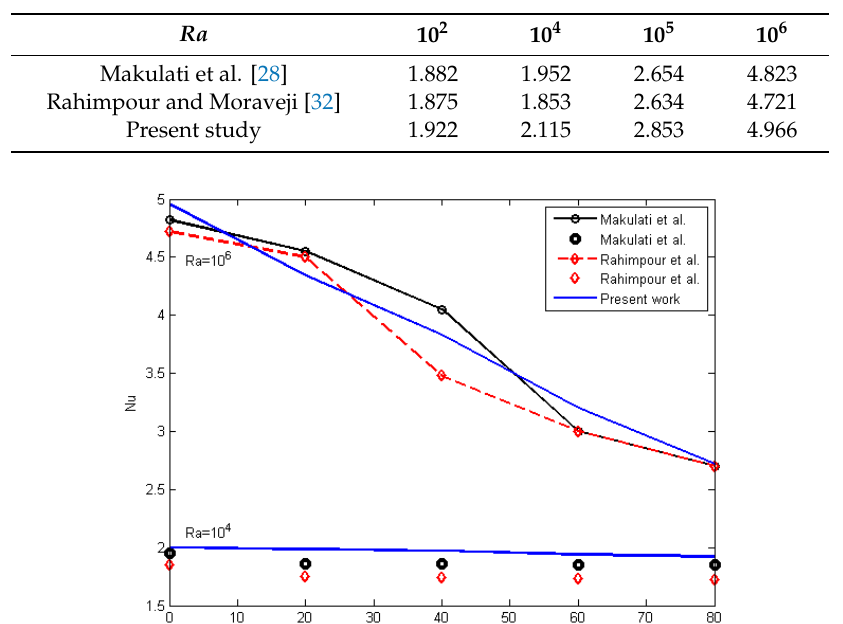
Figure 3. Meshing the solution domain.